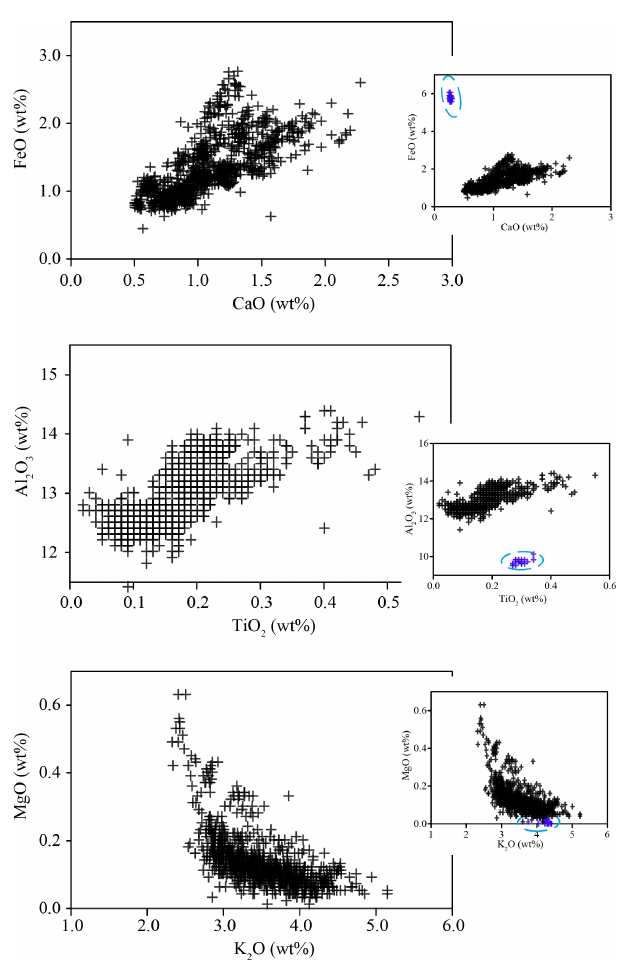
Figure 4. Major-element bivariate plots of glass-shard composi- tions for all reference data (presented on a normalised basis). High- lighted in the insets by blue dashed lines are the Tuhua tephra sam- ples. These are removed from the enlarged figure to allow the detail of the majority of the samples to be seen more clearly. Total iron expressed as FeO.